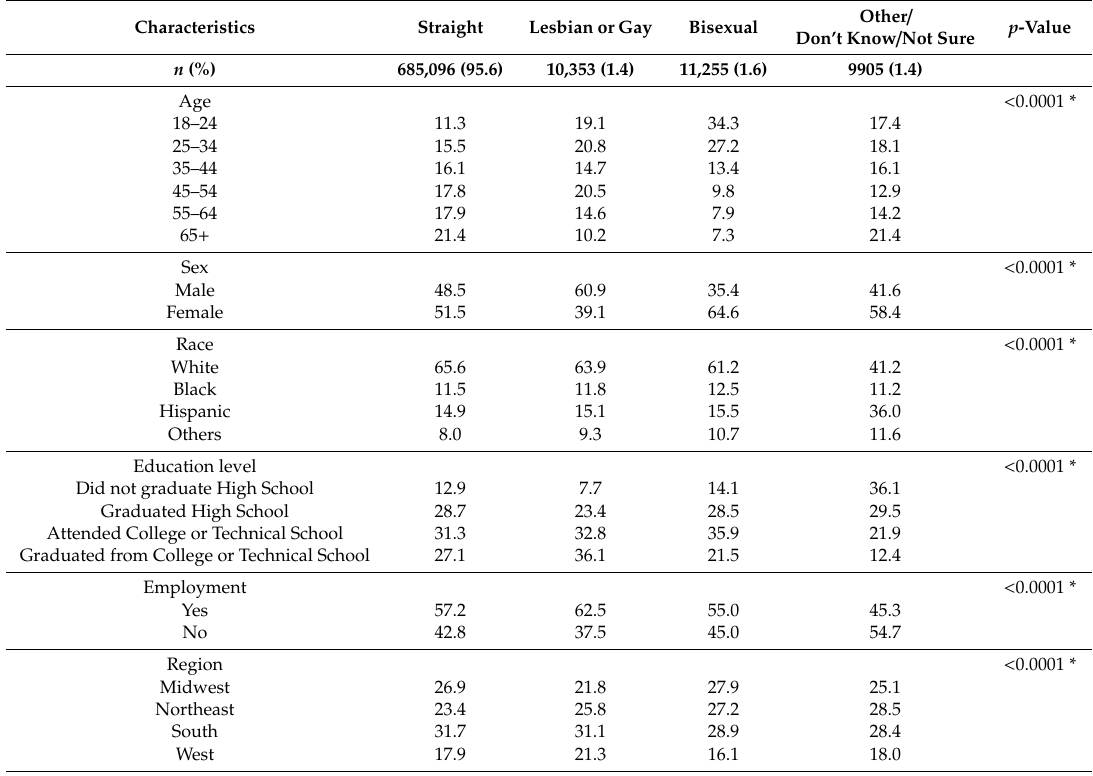
Other / p -Value Don’t Know / Not Sure